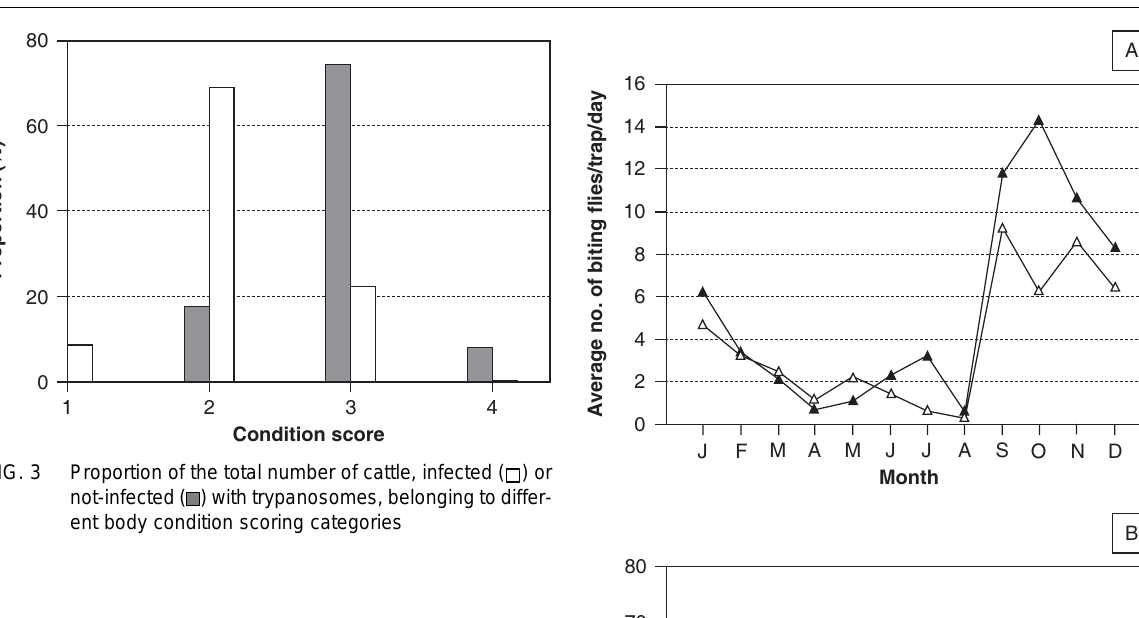
The prevalence of trypanosome infections did not differ between age categories ( P = 0.77) or sexes ( P = 0.09). The average PCV of the animals infect- ed with trypanosomes was 21.1 ± 3.4% and 20.9 ± 2.5 % in the tsetse-free area and tsetse-infested study area, respectively. It was significantly lower ( P = 0.001) than the average PCV of the animals that were parasitologically negative (28.1 ± 5.2 % and 26.9 ± 5.2% for the tsetse-free area and tsetse-